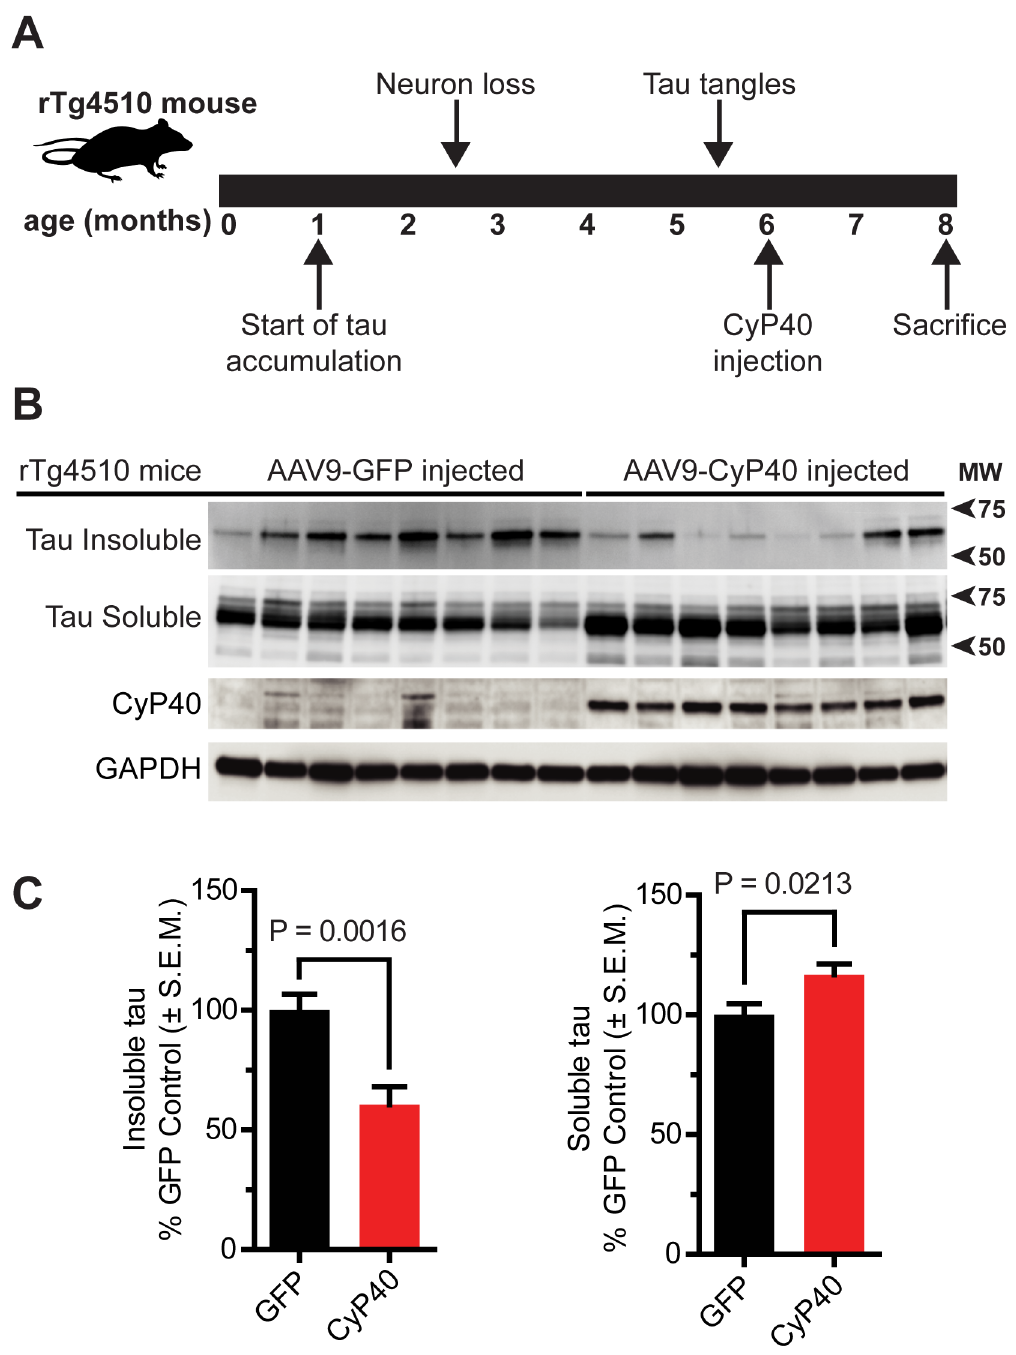
Fig 2. Cyclophilin 40 (CyP40) overexpression decreasedsarkosyl-insoluble tau. (A) Schematicdepictingthe timeline of rTg4510 tau pathologyand experimental design. (B) Western blot comparing sarkosyl-insoluble and sarkosyl-soluble fractions from the hippocampi of adeno-associatedvirus serotype 9–greenfluorescent protein (AAV9-GFP) ( n = 8) and AAV9-CyP40( n = 8) injectedrTg4510 mice. Each lane indicatesan individual transgenic mouse. (C) Quantification of the relativeinsolubleand solubletau for AAV9-GFP and AAV9-CyP40 injected mice (unpaired t test, n = 8 for each group). The numerical data used in panel 2C can be found in S1 Data. GAPDH, glyceraldehyde 3-phosphate dehydrogenase; SEM, standarderror of the mean.